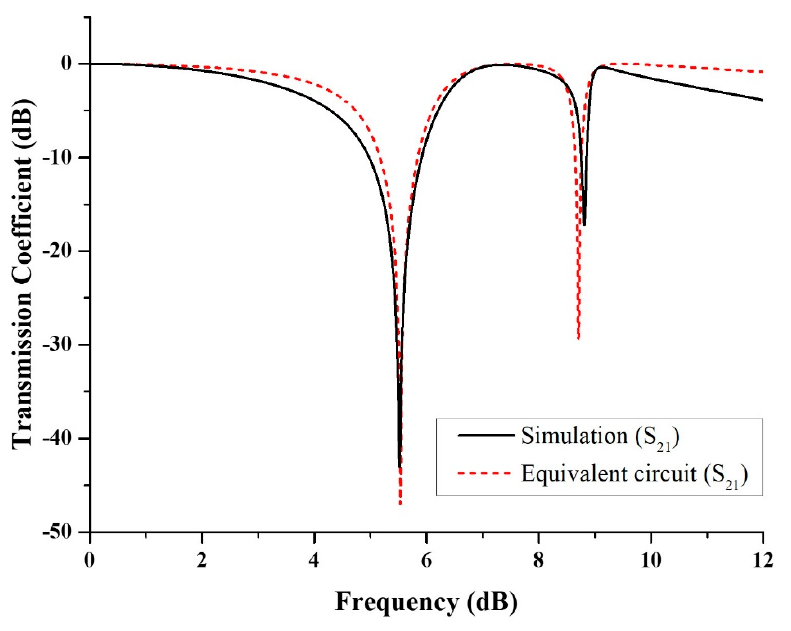
Figure 5. The comparison of S 21 results for simulation and equivalent circuit.